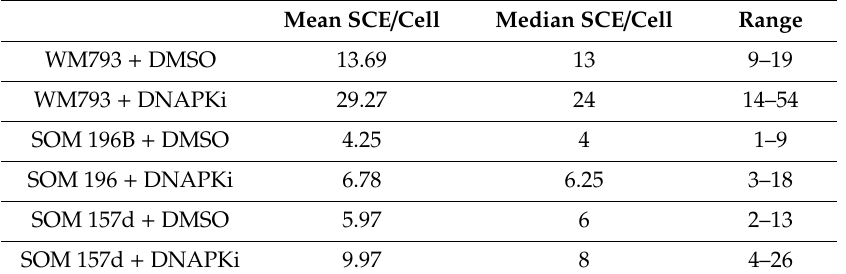
Table 1. DNA-PK inhibition raises sister chromatid exchange (SCE) levels in UM in a proportional